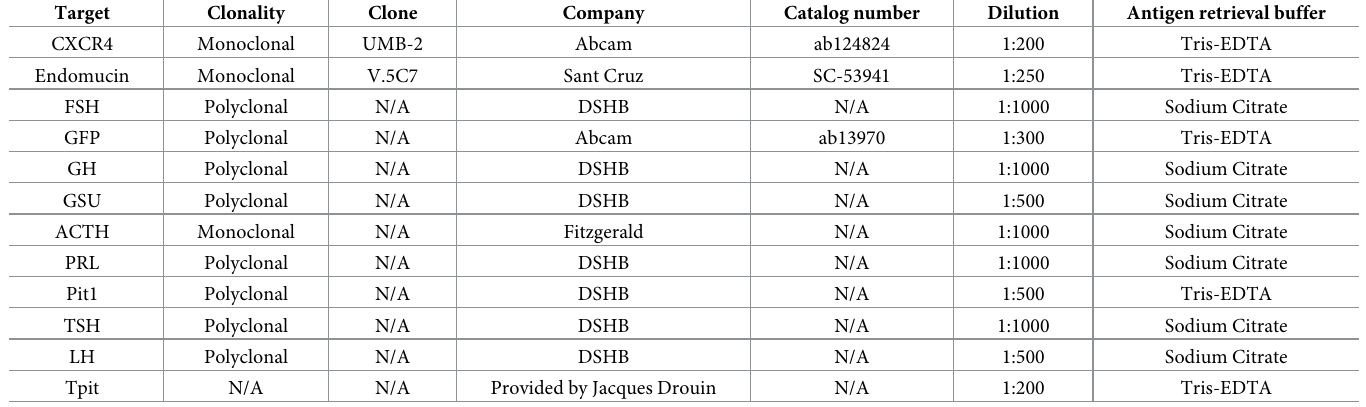
Table 1. List of primary antibodies used in this study.